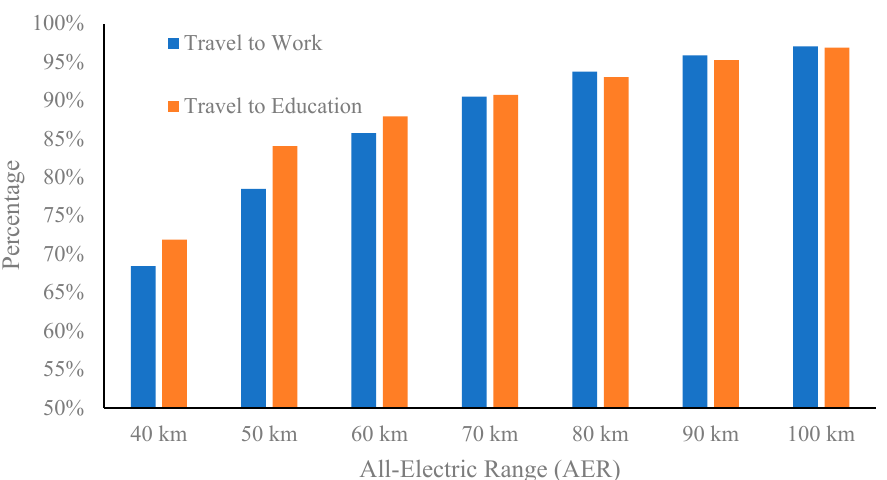
Figure 2. Proportion of car travel to work and education that can be replaced by EVs with different AERs (weekday).